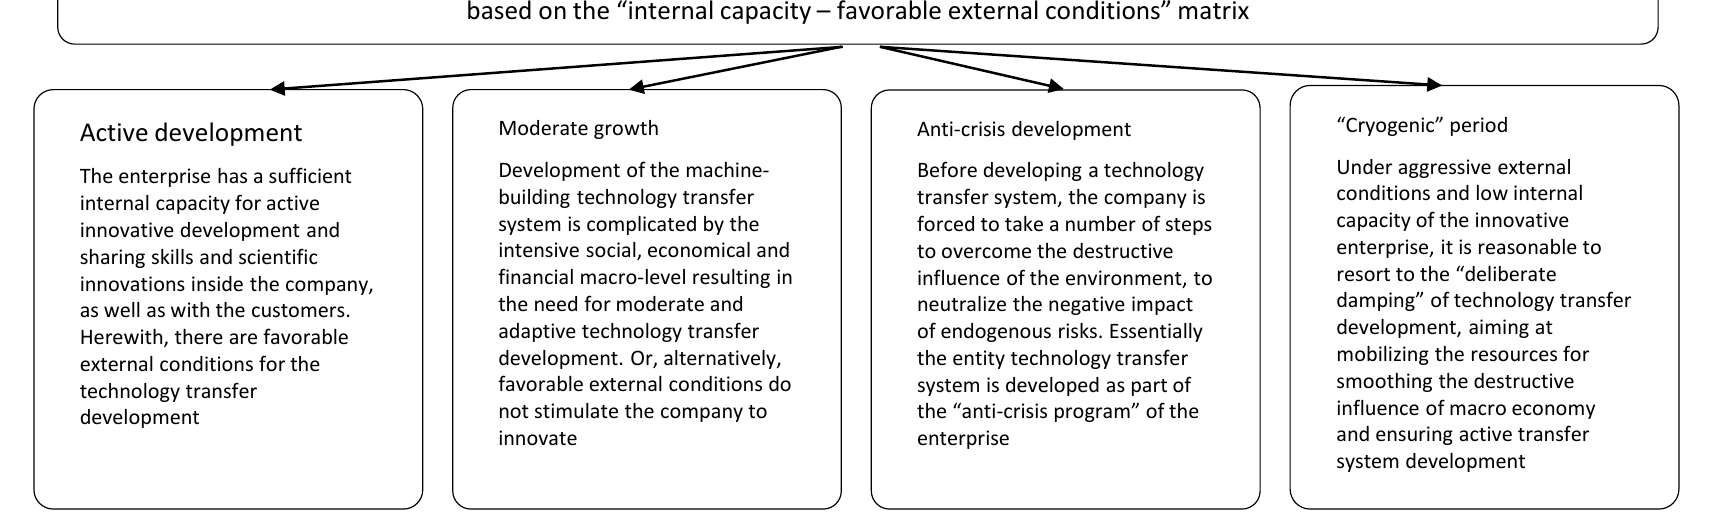
Figure 1. Procedure for determining the capacity for intra-firm technology transfer system development at machine-building